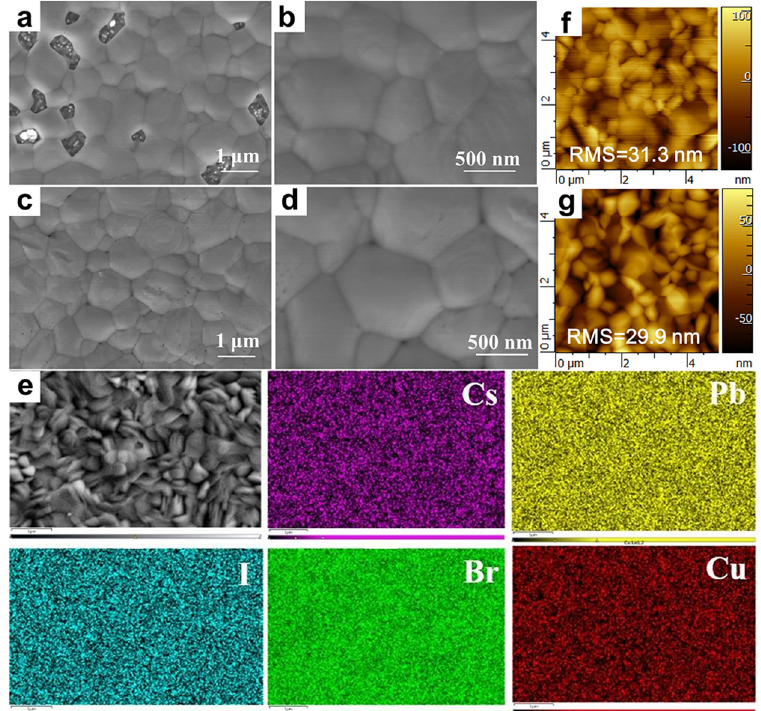
Figure 3. Top-view SEM images of ( a , b ) CsPbIBr 2 and ( c , d ) CsPbIBr 2 -0.50%Cu films at different magnifications. ( e ) EDX elemental mapping images of CsPbIBr 2 -0.50%Cu film including Cs, Pb, I, Br, Cu elements. Top-view AFM images of ( f ) CsPbIBr 2 and ( g ) CsPbIBr 2 -0.50%Cu films.